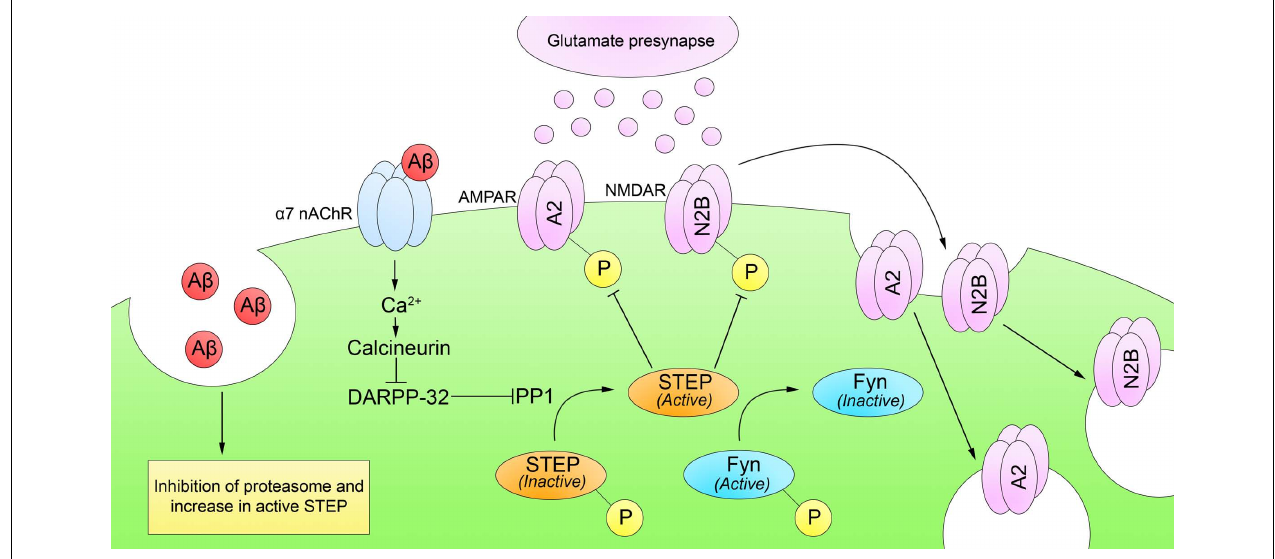
α 7 nAChRs, leading to Ca 2 + influx and activation of calcineurin. Calcineurin/PP1 then dephosphorylates and activates STEP. Active STEP promotes the dephosphorylation of Fyn, GluA2, and GluN2B (and other substrates not depicted). Dephosphorylation of Fyn inactivates it whereas dephosphorylation of GluN2B and GluA2 leads to NMDAR and AMPAR internalization from synaptosomal surface membranes and disruption of synaptic